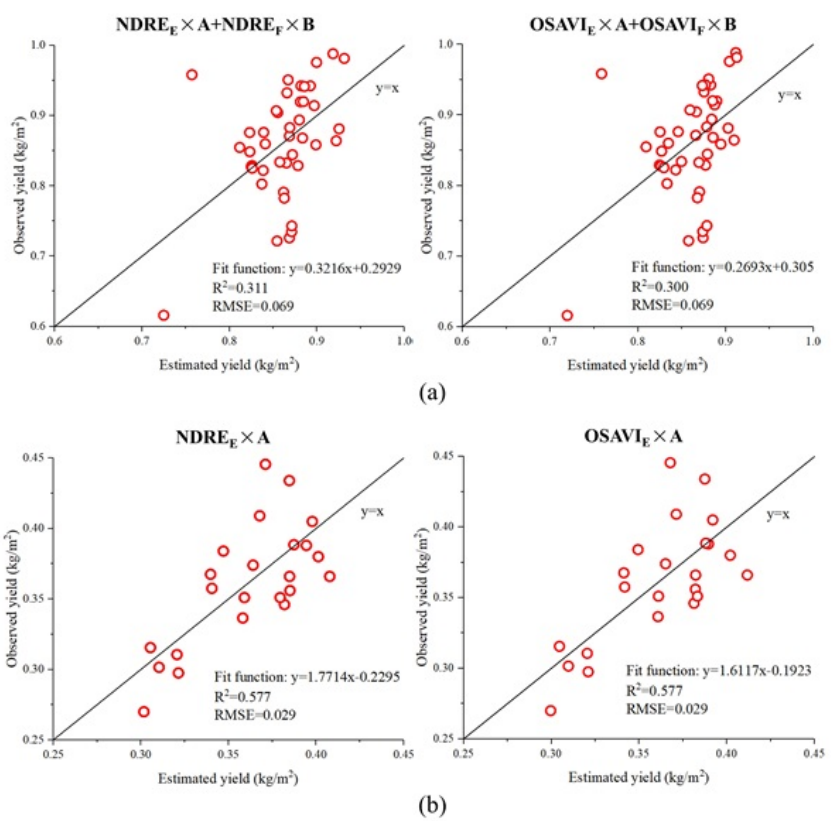
Figure 12. The linear regression results of optimal indices. ( a ) Estimated yield vs. observed yield in Study Area 1 Lingshui, and ( b ) estimated yield vs. observed yield in Study Area 2 Wuxue.